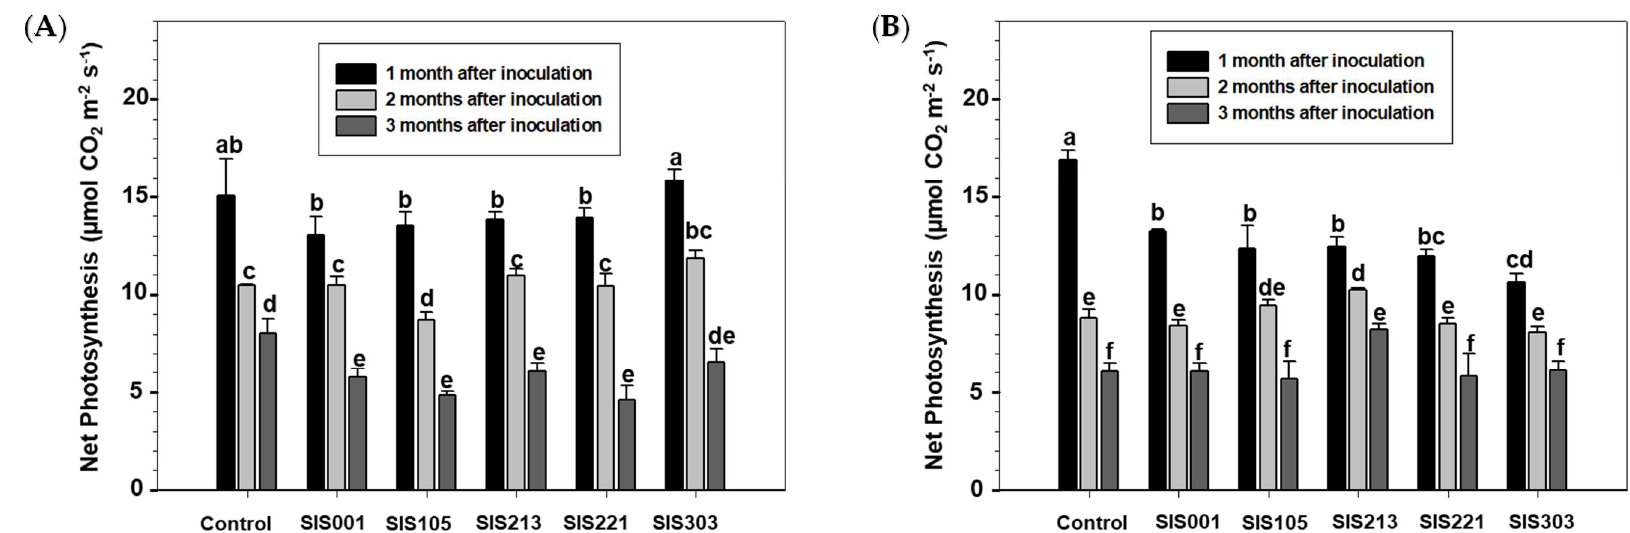
Figure 3. Effect of rhizobacteria inoculation on net photosynthesis of ( A ) Tres Cantos and ( B ) cherry plants. Net CO 2 assimilation was measured in mature leaves at 1, 2 and 3 months after inoculation with PGPR. Data are the means ± SE of 3 replicates. Values marked with different letters within each panel are significantly different according to Duncan’s multiple range test, p < 0 . 05.